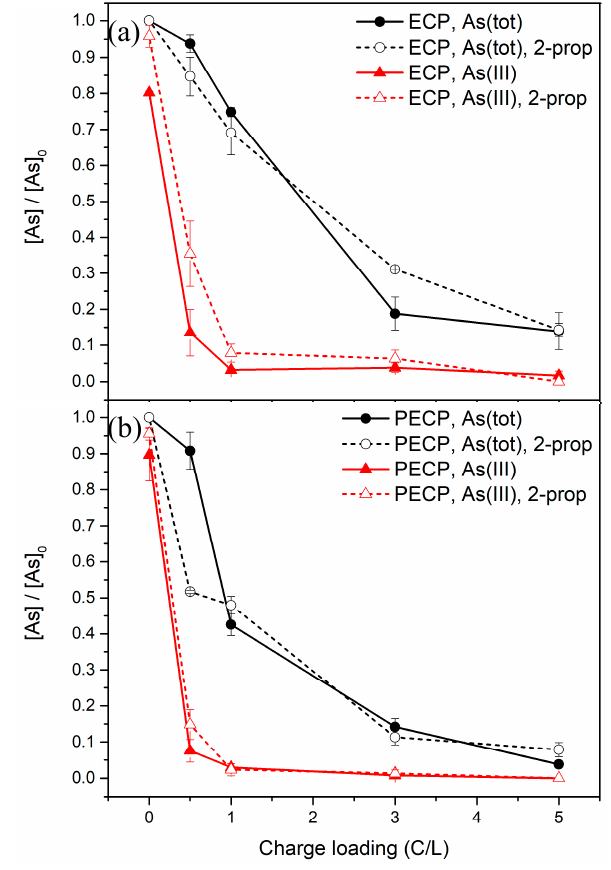
Figure 4. Profile of ( (cid:78) , (cid:52) ) As(III) and ( • , ) total arsenic during ( a ) electrochemical peroxidation, (cid:35) ( b ) photo-assisted electrochemical peroxidation. Solid symbols indicate blank experiments in the absence of 2-propanol scavenger. Empty symbols indicate experiments conducted in the presence of 2-propanol scavenger.